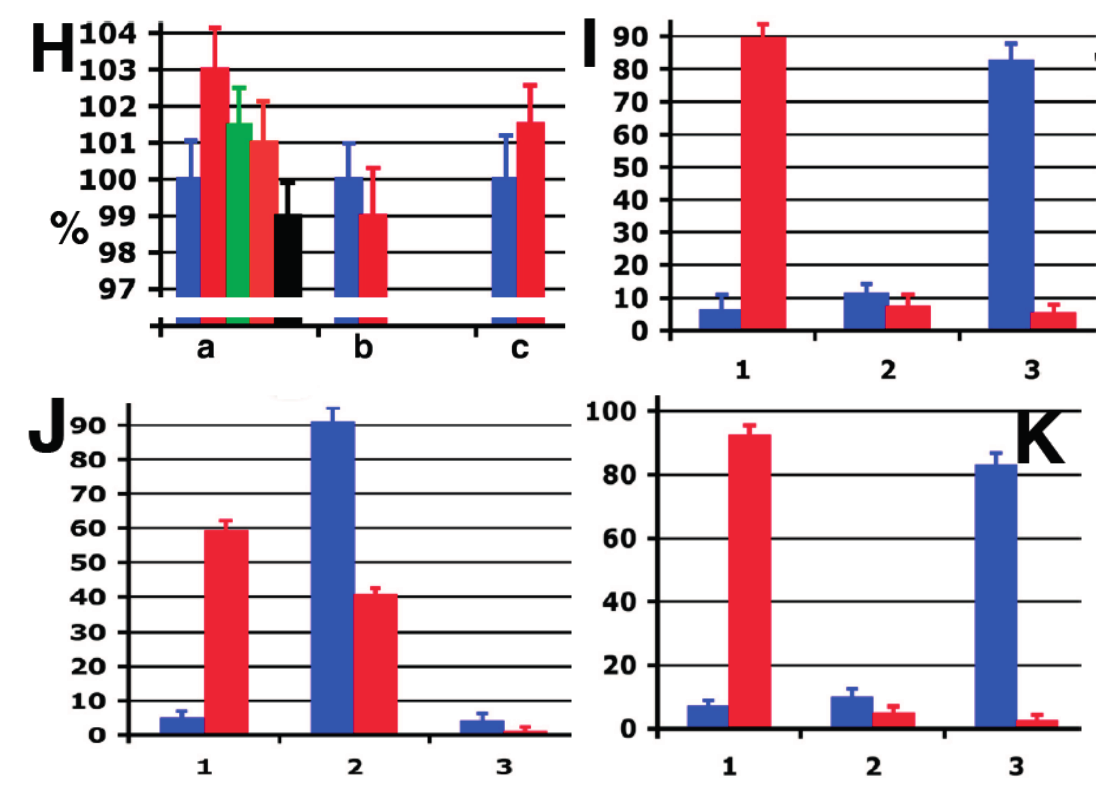
Figure 6. Protein machineries that are involved in GA shaping. ( A , B ) The ldl F cells were treated at 40 °C for 6 h, permeabilized with streptolysis O (SLO), then incubated with native cytosol, the ATP restoration system (ARS), GTP and a mixture of anti-GRASP55 and GRASP65 antibodies for 90 min, and prepared for electron microscopy (EM; A ) or immuno-nano-gold-EM labeling for ManII ( B ). Arrows show non-stacked Golgi cisternae ( A ) or COPI-coated buds ( B ); ( C ) Isolated Golgi membranes were incubated with COPI-depleted cytosol and ARS/GTP and then re-isolated. Arrows show individual cisternae; ( D , E ) HeLa cells were microinjected with the mutants of α SNAP protein ( α SNAPmu), then placed on ice for 10 min, treated with BFA for 30 min, and then prepared for EM ( D ) or immunofluorescence ( E ; anti- β COP, red; anti-mannosidase II (ManII, green); ( F ) HeLa cells were microinjected with a mixture of α SNAPmu and an anti- β -COP antibody, and after 30 min prepared for EM; ( G ) Ldl F cells were treated at 40 °C for 6 h and permeabilized with SLO, and then incubated with COPI-depleted cytosol and ARS/GTP, plus α SNAPmu, for 90 min; ( H – K ) Quantification of mean Golgi membrane curvature; ( H ) Ratio between the cytosolic and luminal surface areas (a); integrated mean curvature (b); and tomographic estimation (c). Data were normalized with respect to the curvature 5 min after NZ treatment. Note: the Y -axis in H is shown with a break; ( I – K ) Distribution of surface area (blue bars) and TAA (red bars) between 50–60 nm RPs (1 in H – K ), elongated profiles (2 in B – D ) and cisternae (3 in H – K ) after treatment of HeLa cells with NZ (5 min, I ); NZ (5 min) and then NZ + BFA (5 min, J ); or NZ (5 min), NZ + BFA (5 min) followed by BFA washout in the presence of NZ (5 min, K ). For details on curvature quantification, see Supplementary Materials. Bars, 500 nm ( A ); 300 nm ( B ); 200 nm ( C , D , F ); 5 µm ( E ); 400 nm ( G